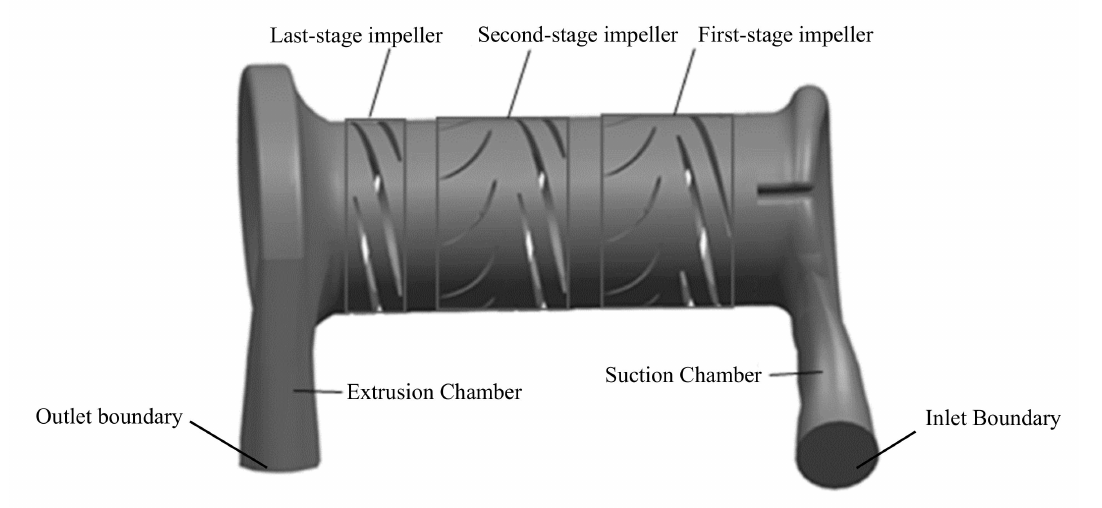
Figure 4. The three-dimensional model of the multiphase